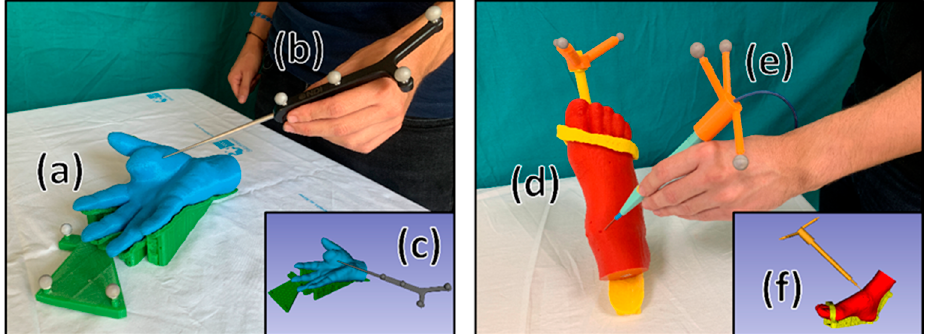
Figure 3. Image-guided surgery simulation on patient-specific 3D printed phantoms based on case 1 (left) and case 2 (right). The user is recording points from the conical holes made on the surface of the 3D printed phantoms ( a , d ) with the commercial pointer ( b ) in case 1, and with the electric scalpel ( e ) in case 2. The corresponding virtual scenes are shown in ( c , f ).